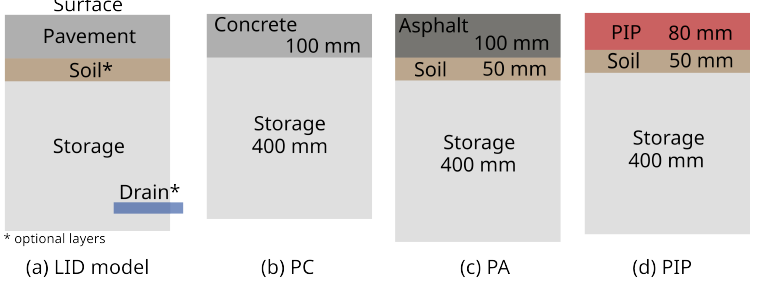
Figure 1. PP layouts for ( a ) general SWMM model, and tested ( b ) PC, ( c ) PA, and ( d )